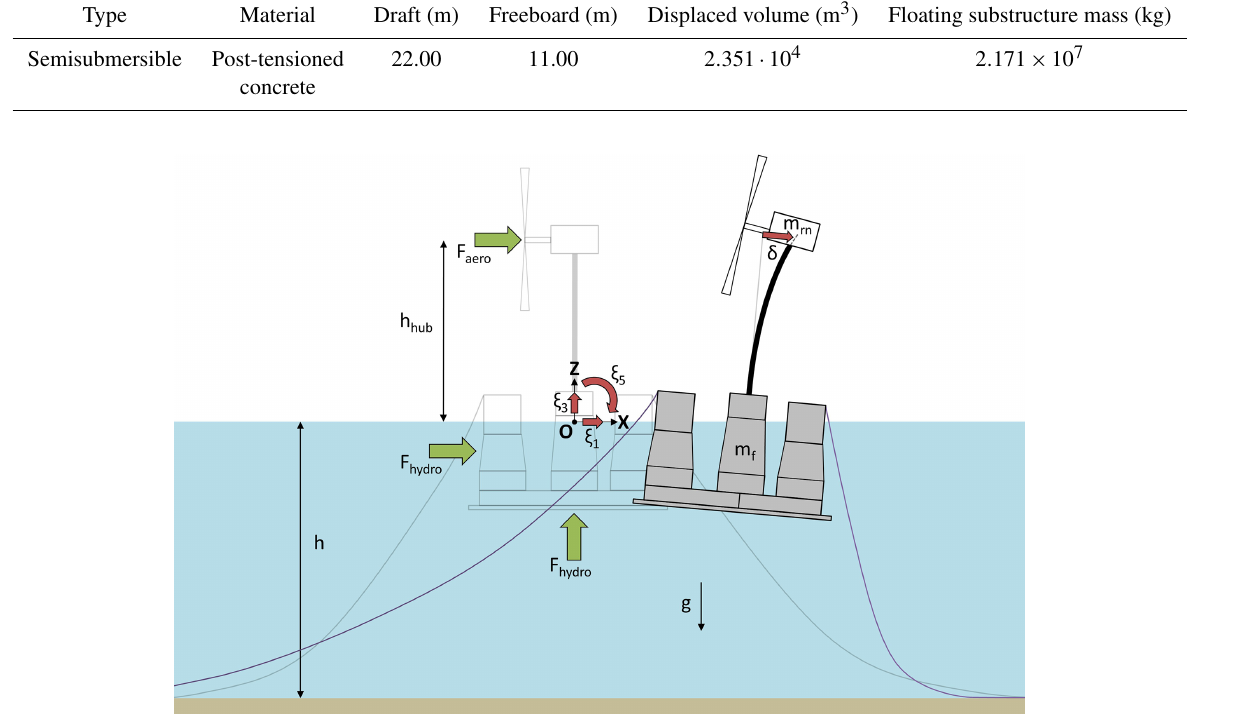
mooring line model that allows the use of multi-segmented mooring